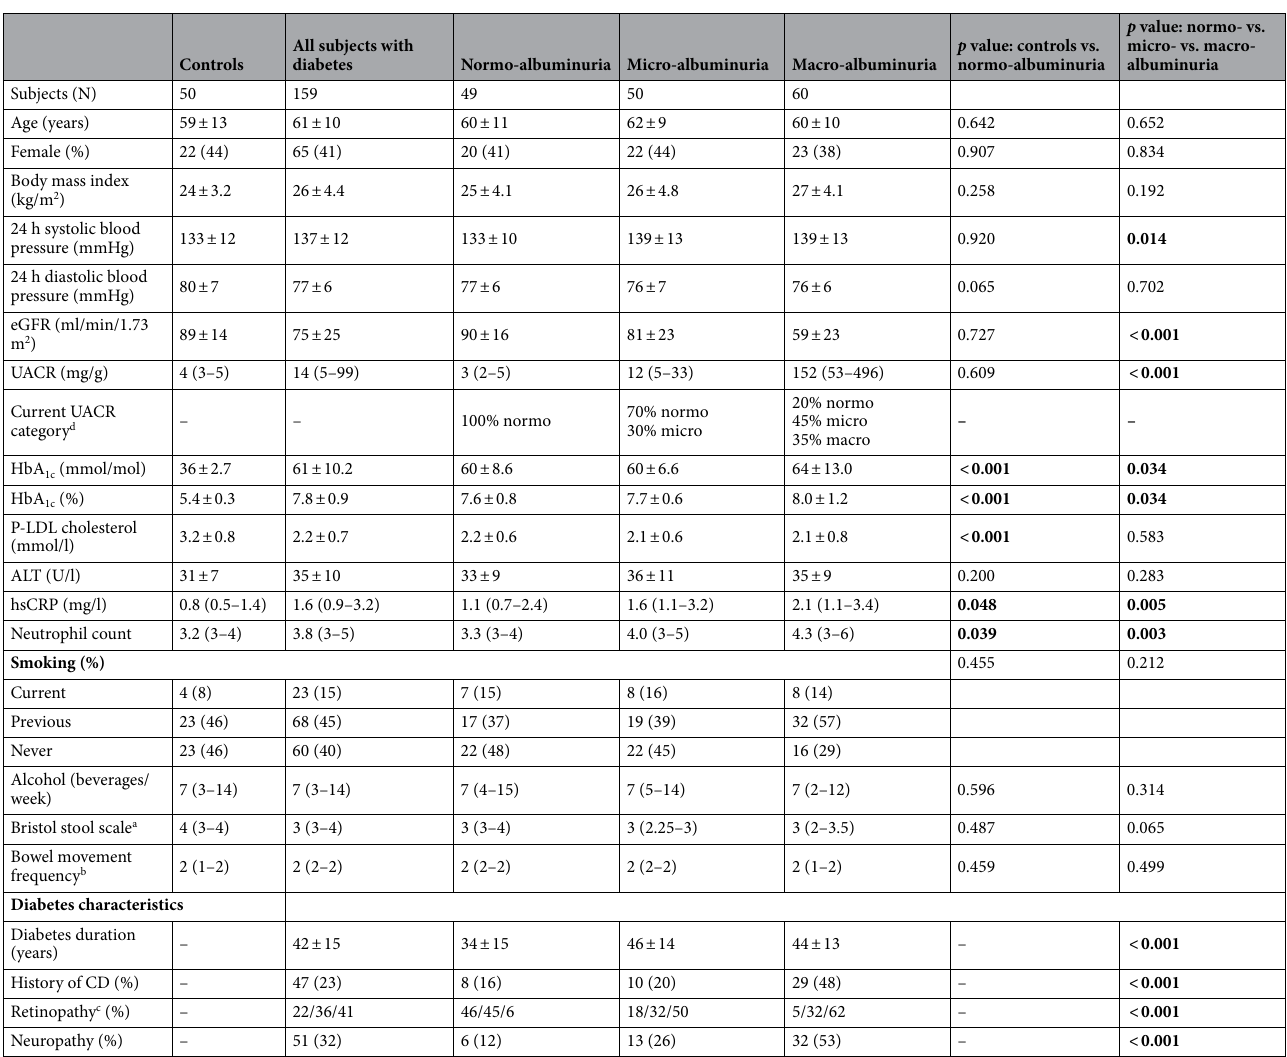
Table 1. Clinical characteristics of the study subjects at the current visit. Data are shown as n (%), mean ± standard deviation or as median (interquartile range). ALT alanine transaminase, hsCRP high- sensitivity C-reactive protein, CD cardiovascular disease. p values were calculated with unpaired Students’ t test or analysis of covariance (ANCOVA covariates were age, sex, 24-h systolic blood pressure and eGFR) for continuous variables and the χ 2 test for categorical variables. a Bristol stool scale from 1 to 7. b Bowel movement frequency 1–4; 1 = Twice daily or more, 2 = Once daily, 3 = Every other day and 4 = Less than every other day. c No/non-proliferative/proliferative. eGFR estimated glomerular filtration rate, UACR current urinary albumin creatinine rate. d Based on results from the three albuminuria measurements at study visit. Albuminuria values (e.g. albuminuria category) may be reduced compared to the historic albuminuria measurements due to kidney protective